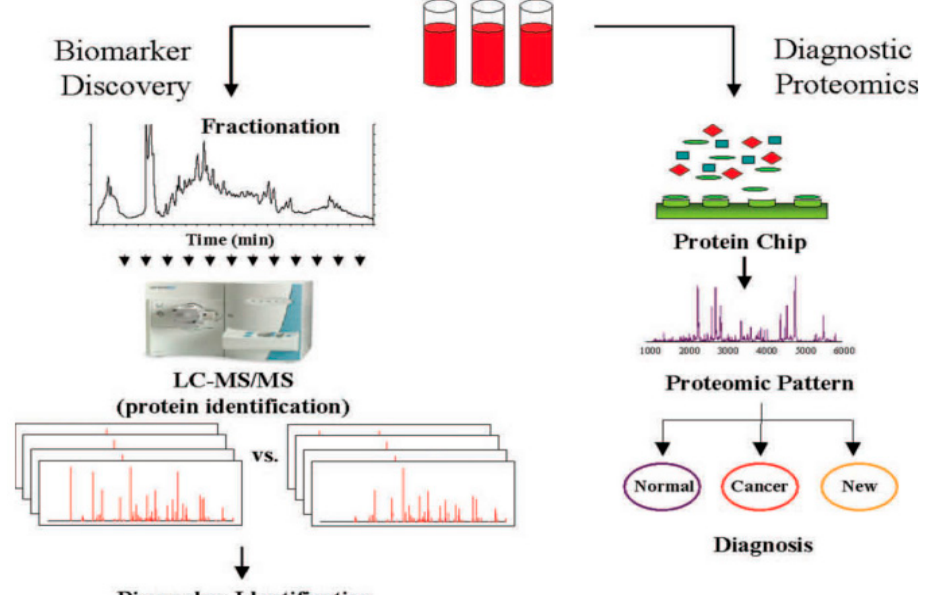
Figure 3. MS-based methods for biomarker discovery (left side) and pattern-based diagnostic proteomics (right side). (Reprinted/adapted with permission from Ref [38]. Copyright year 2005.)